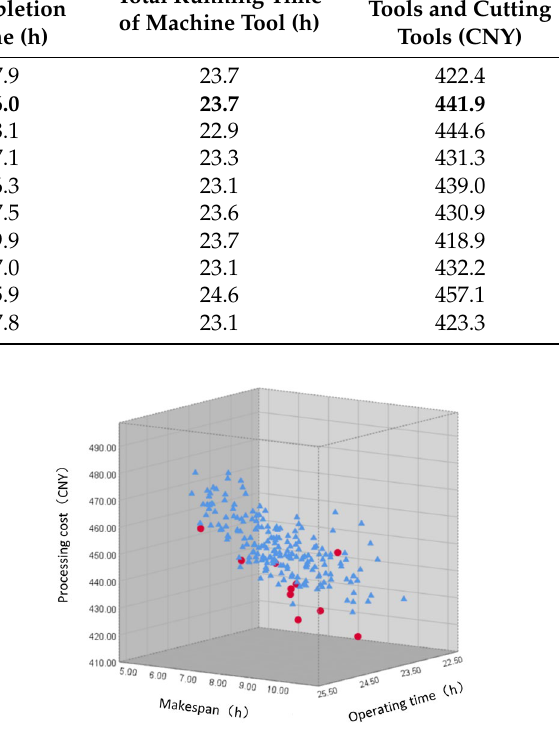
Figure 15. Pareto scatter plot of improved HBMO algorithm.